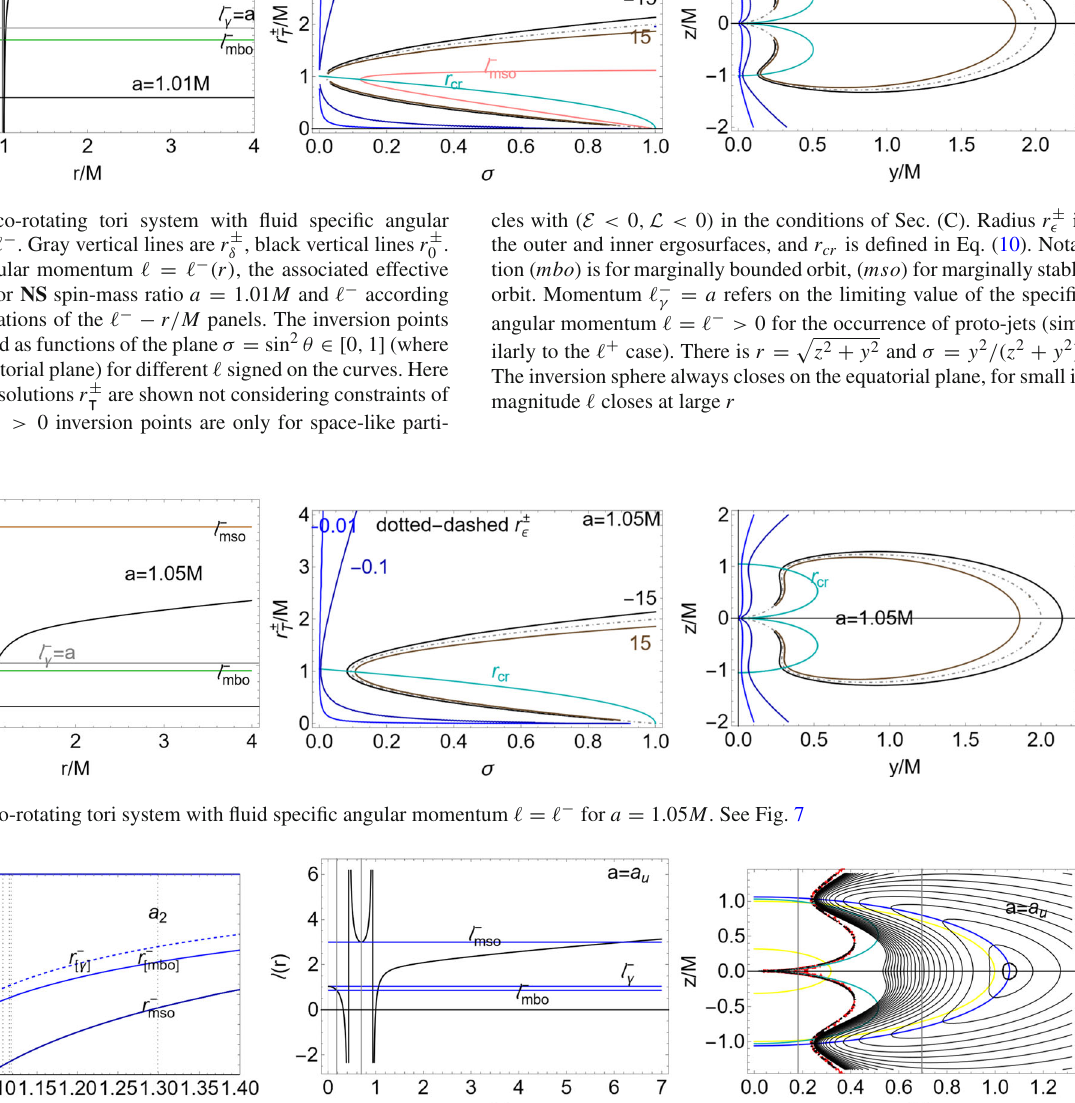
the extended geodetical structure. Center panel: fluid specific angular ) . Double momentum (cid:6)( r ) in the spacetime a u : K ( r − mso ) = K ( r − [ mbo ] co-rotating tori are possible for (cid:6) > (cid:6) − mso . Right panel: toroidal configu- rations in the geometry a u with specific angular momentum (cid:6) = 1 . 025. The proto-jets with cusp very close to the central singularity. There (cid:6) (cid:6) z 2 + y 2 and θ = arcsin y / z 2 + y 2 . Cyan curve is radius is r = r cr = r + (cid:2) = r − (cid:2) , defined in Eq. (10). Blue curve contains pressure max- ima (the tori centers, dependent on (cid:6) only) and tori geometric maxima = 0 in the plane ( y , z ) , in (dependent on K and (cid:6) ), solutions of ∂ r V 2 ef f this case it is r = a